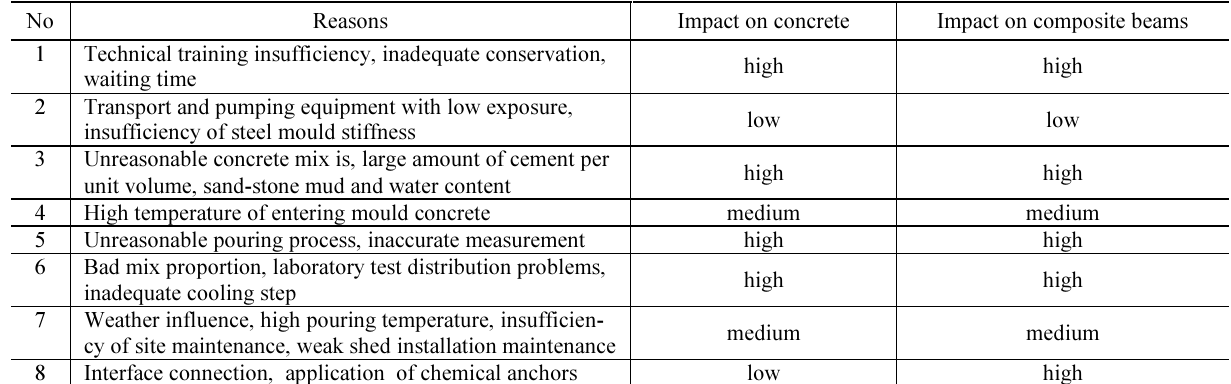
Table 3. Reasons and degree which affect concrete quality